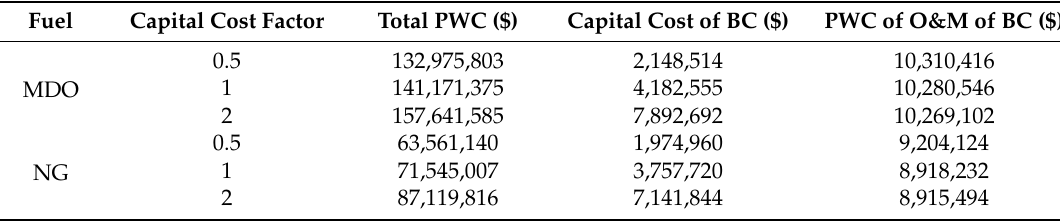
Table 18. Optimal PWC and bottoming cycle (BC) costs for varying capital cost